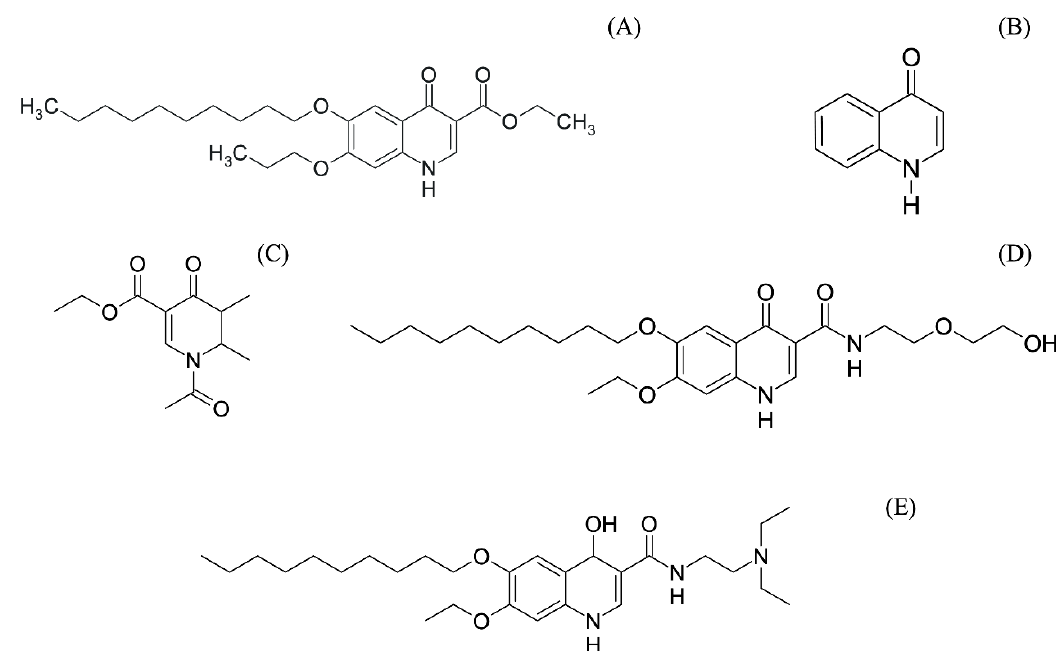
Figure 2. Structures of DQ derivatives with enhanced physicochemical properties for therapeutic use. ( A ) DQ, ( B ) 4-hydroxyquinoline [15], ( C ) N -acetyl 30 [16], ( D ) derivative RMB041 [17], ( E )